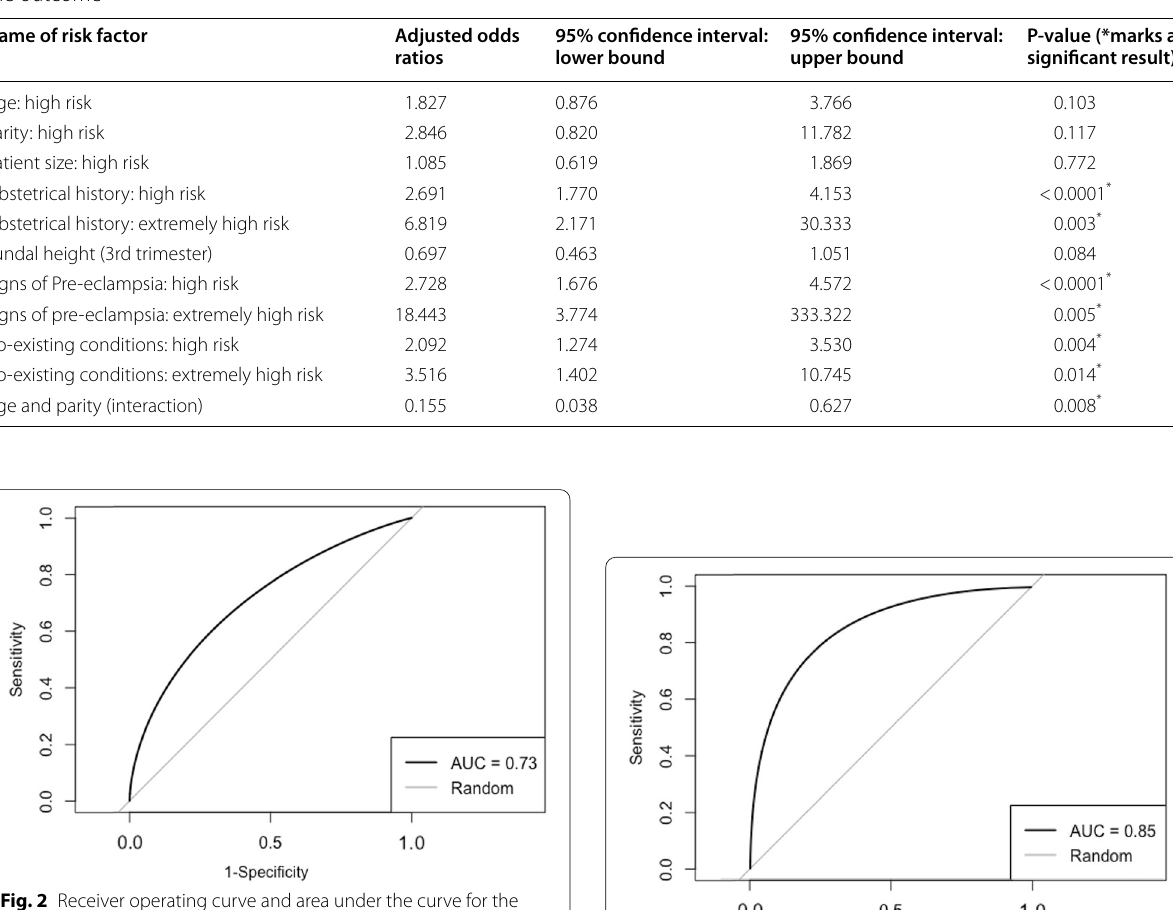
Table 3 Multivariate logistic regression analysis for the risk factors included in the CMDS with the need for a skilled birth attendant as the outcome